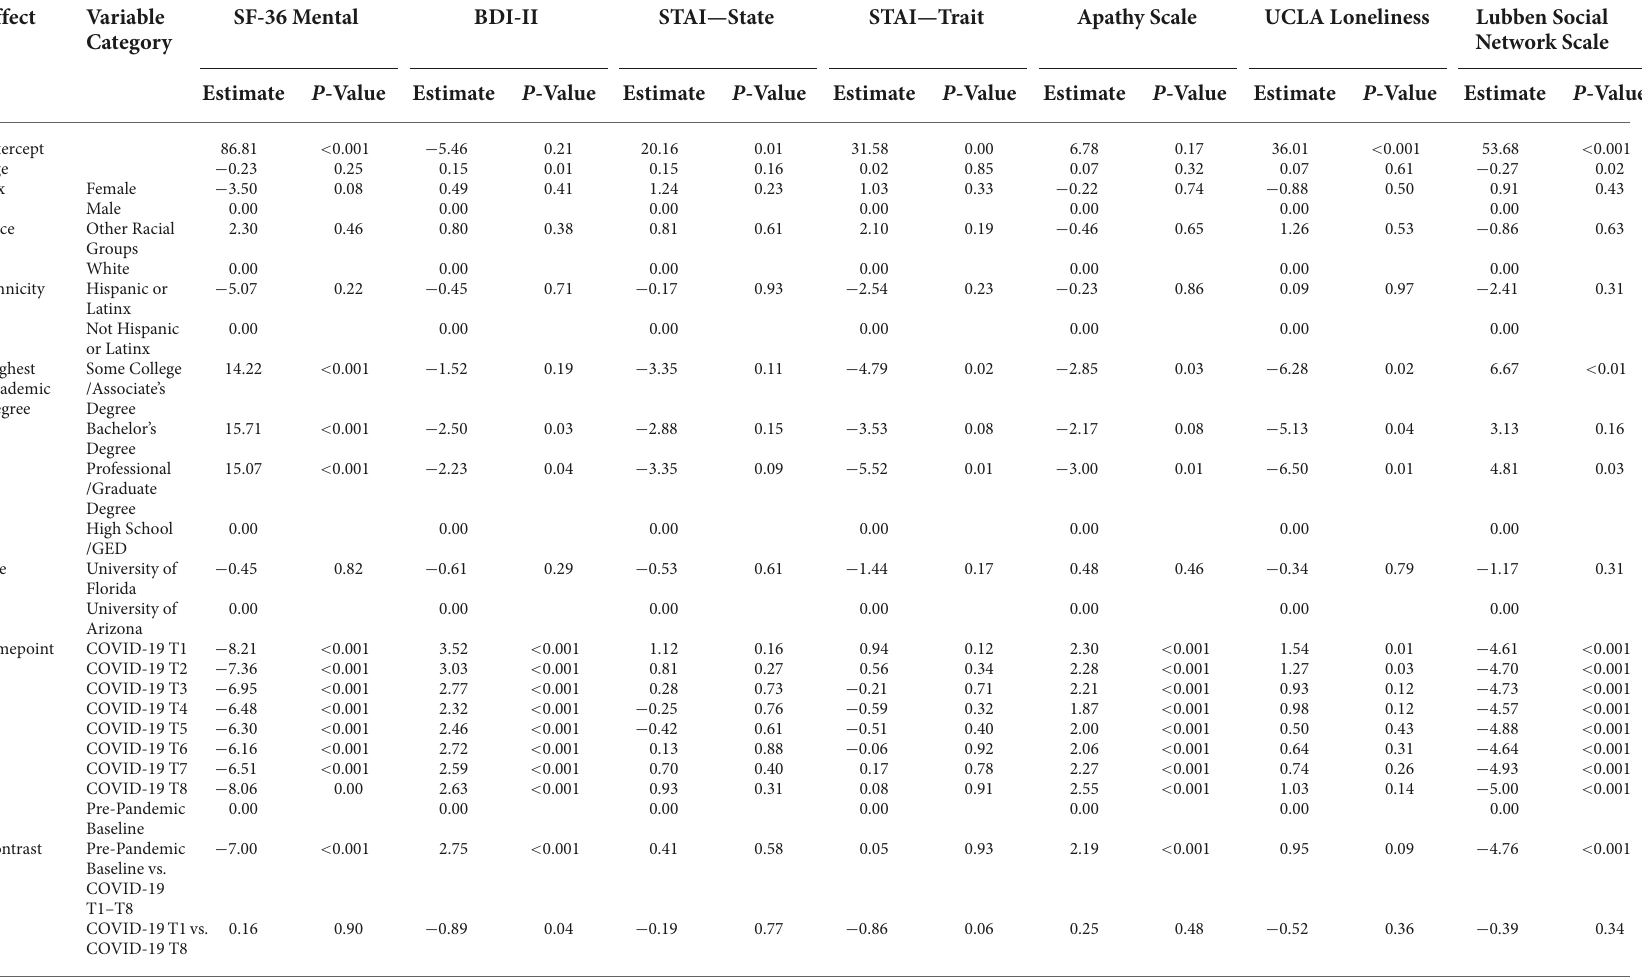
TABLE 4 Psychosocial factors